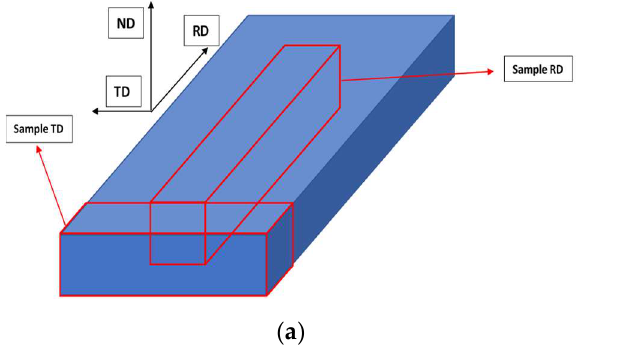
Figure 3. B-scans of the 70% deformed heat-treated 316 sample with rotation around the ( a ) TD and ( b ) RD axis.